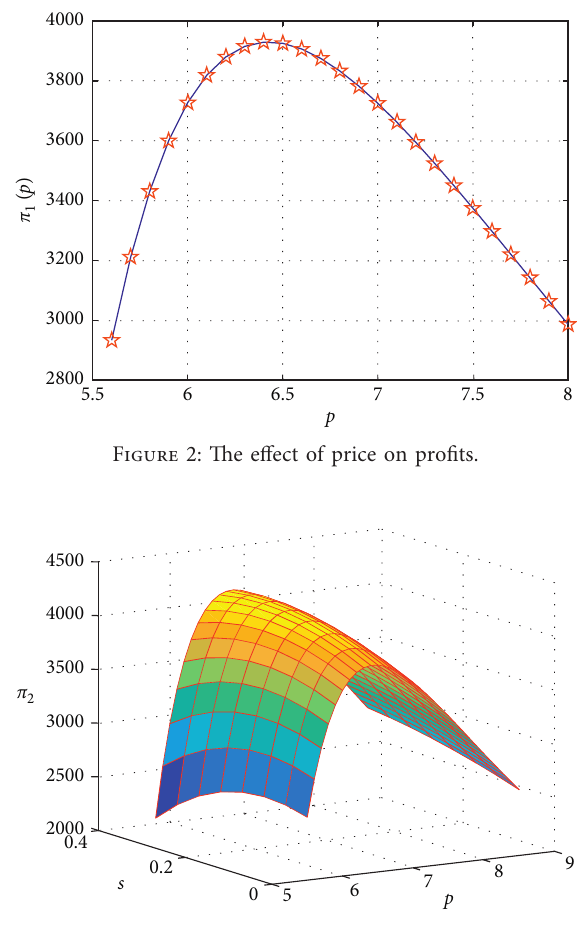
Figure 3: Impact of price and experiential services on profitability. Table 2: Impact of different preference combinations on the de- cisions of the apparel retailer.